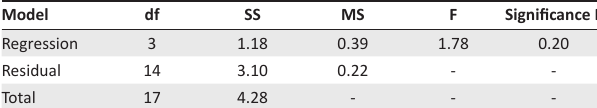
FIGURE 5: Relationship between Normalised Difference Vegetation Index and Standard Precipitation Index TABLE 4a: Summary of outputs. TABLE 4b: Summary of outputs – ANOVA.